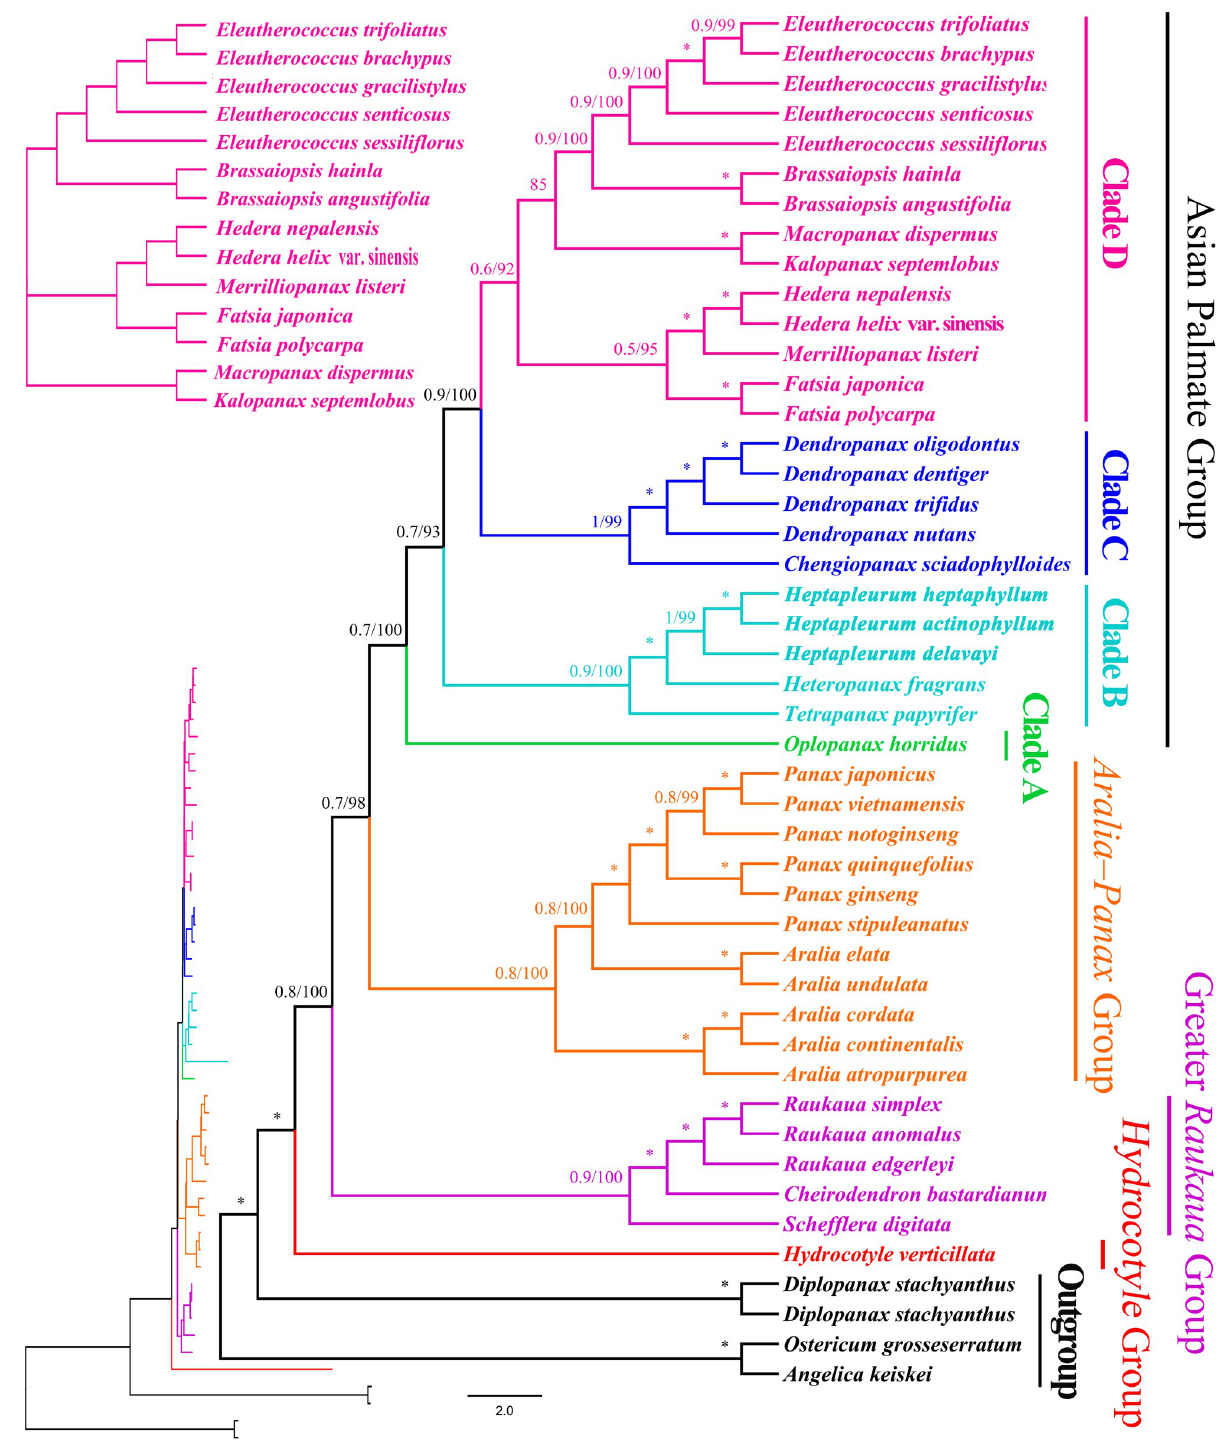
Fig 7. Molecular phylogenetic tree of 42 taxa of Araliaceae based on plastome sequences using unpartitioned Bayesian inference (BI) and maximum likelihood (ML). Numbers at each node are bootstrap support values. The tree is rooted in the plastome sequences of Angelica keiskei , Ostericum grosseserratum , and Diplopanax stachyanthus . Numbers associated with the branches are BI posterior probabilities (PP) and ML bootstrap value (BS), and asterisks ( � ) indicate BS/PP of 100/1.00.